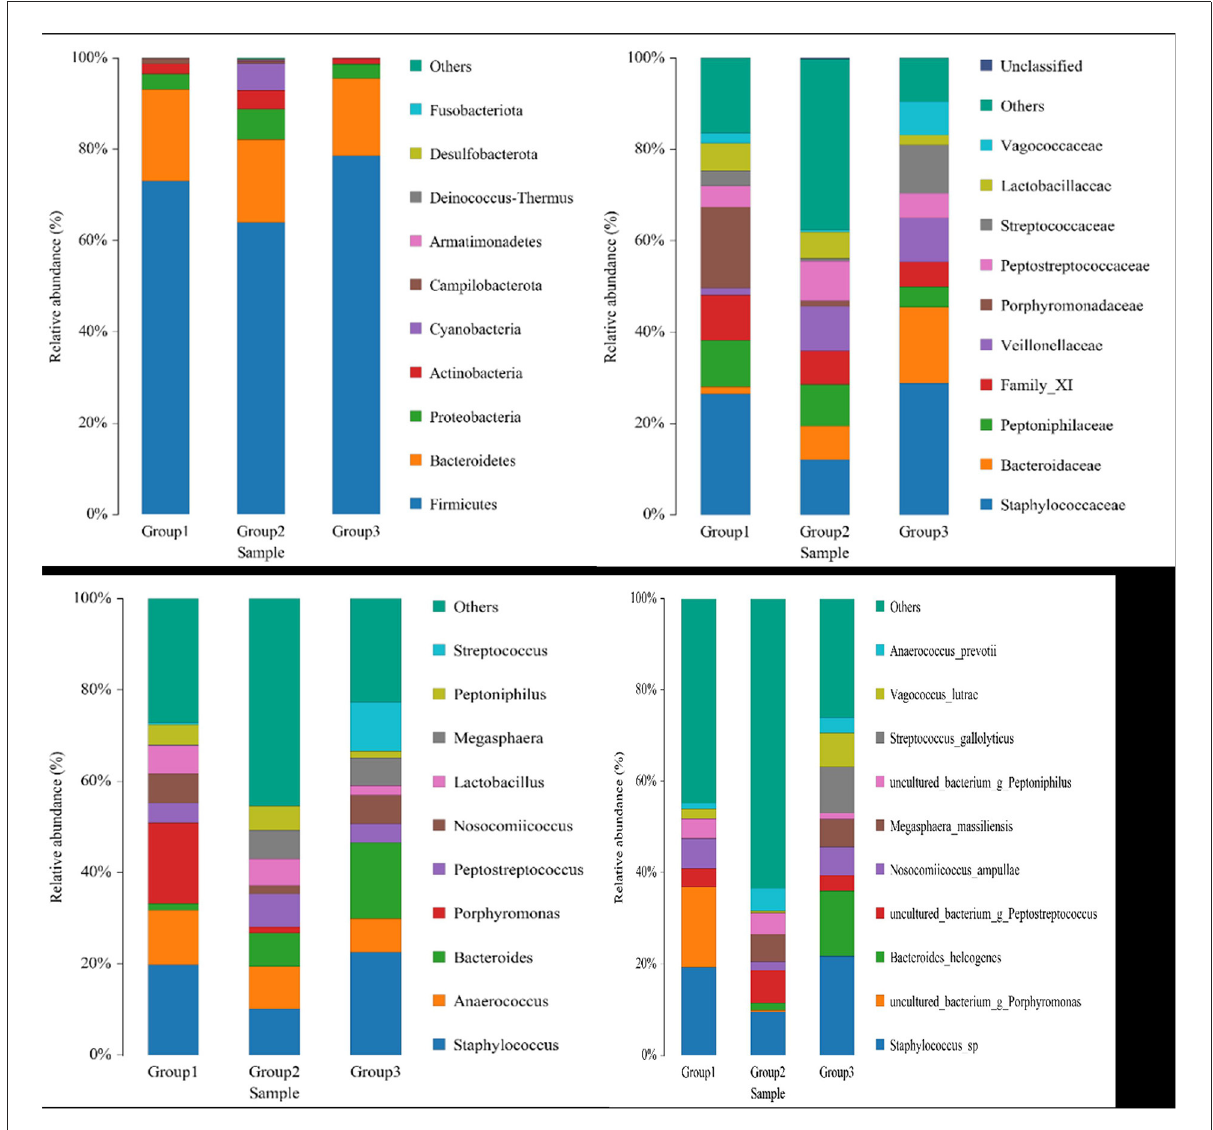
FIGURE3 Species distribution in samples across the three